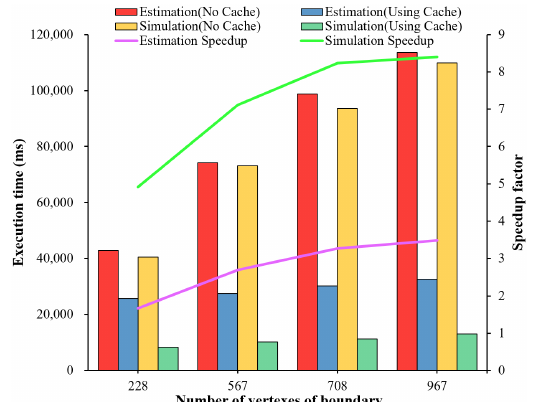
Figure 8. Performance comparison of cross K function with and without weight cache under increasing complexity of